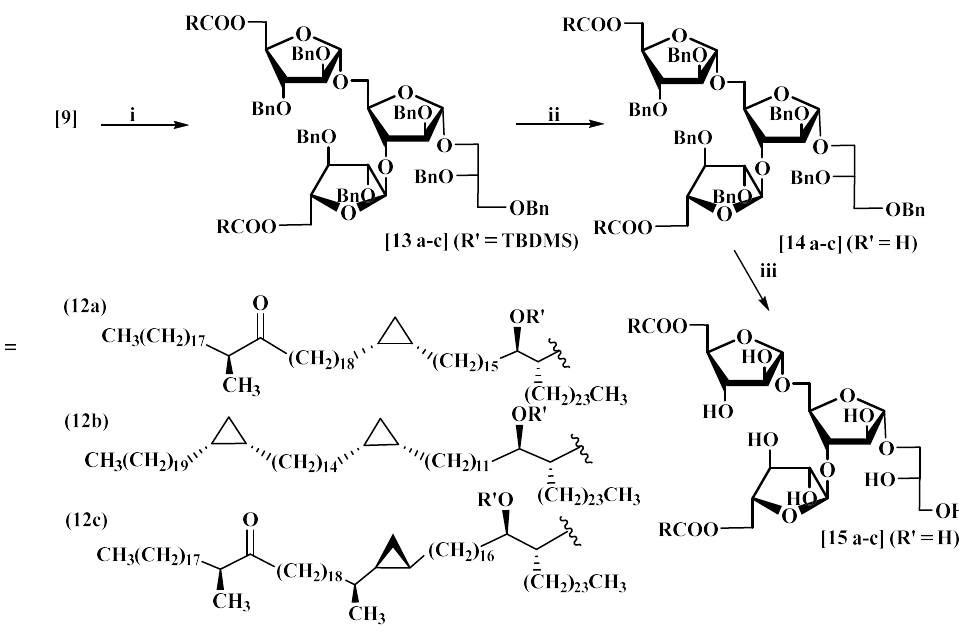
Scheme 5. Synthesis of dimycoloyl triarabinoglycerol (DMTAG) glycolipids. (i) RCOOH (R’